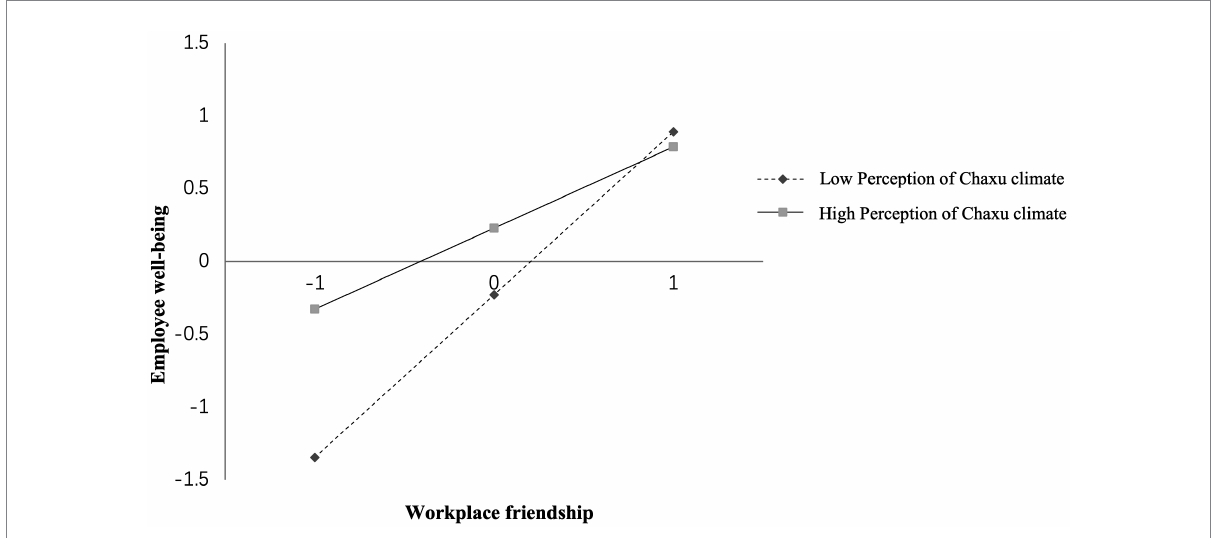
FIGURE 2 The moderating effect of perception of Chaxu climate on workplace friendship and employee well-being.